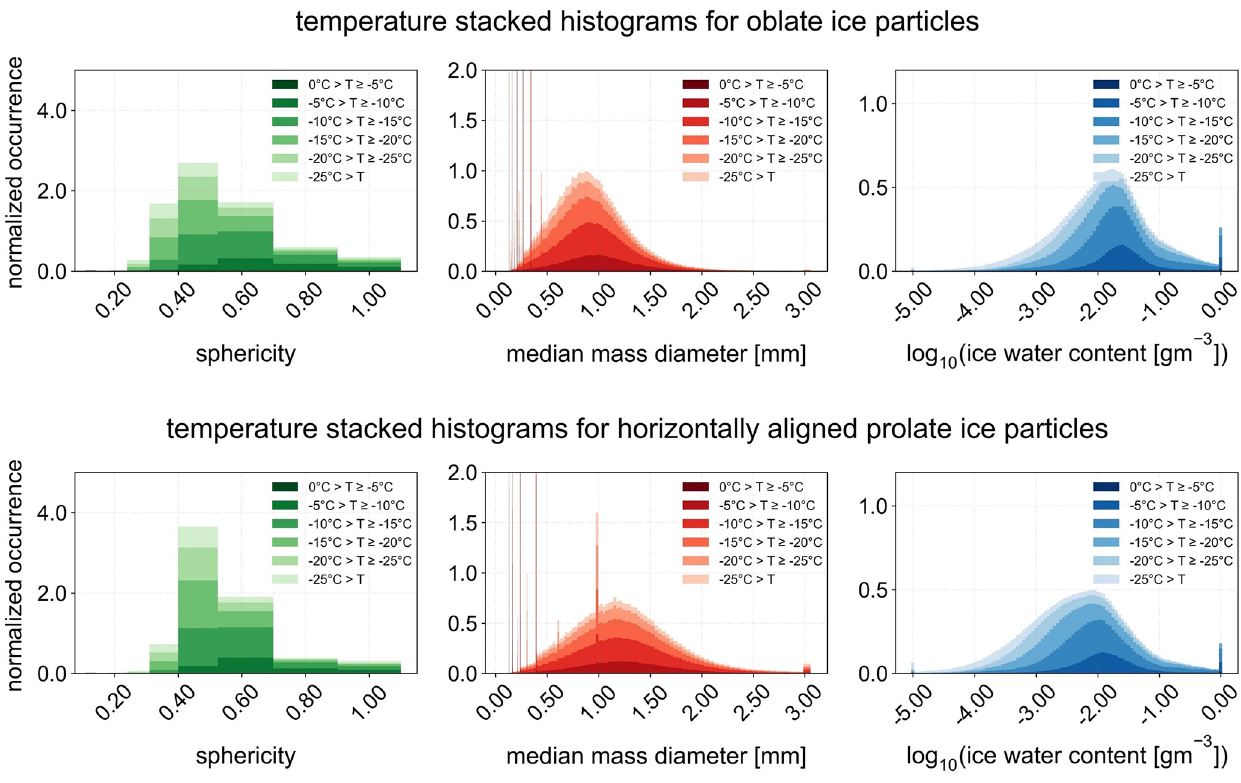
Figure 14. Temperature stacked histograms for all RHI scans on 9, 10, and 30 January 2019 for oblate and horizontally aligned prolate ice particles using the retrieval output for ice spheroids m(D max ) as the aggregates from Yang et al. (2000). Table 3. Statistical description of the retrieved parameters for oblate and horizontally aligned prolate ice spheroids that follow the mass–size relation of aggregates from Yang et al. (2000) for all RHI scans on 9, 10, and 30 January 2019. Shape assumption Statistical description Sphericity Median mass diameter [mm] Ice water content [gm − 3 ] Oblates Median 0.45 0.80 13 × 10 − 3 10th percentile 0.35 0.27 11 × 10 − 4 90th percentile 0.80 1.36 11 × 10 − 2 Horizontally aligned prolates Median 0.45 1.08 5 × 10 − 3 10th percentile 0.45 0.40 4 × 10 − 4 90th percentile 0.80 1.82 6 × 10 −